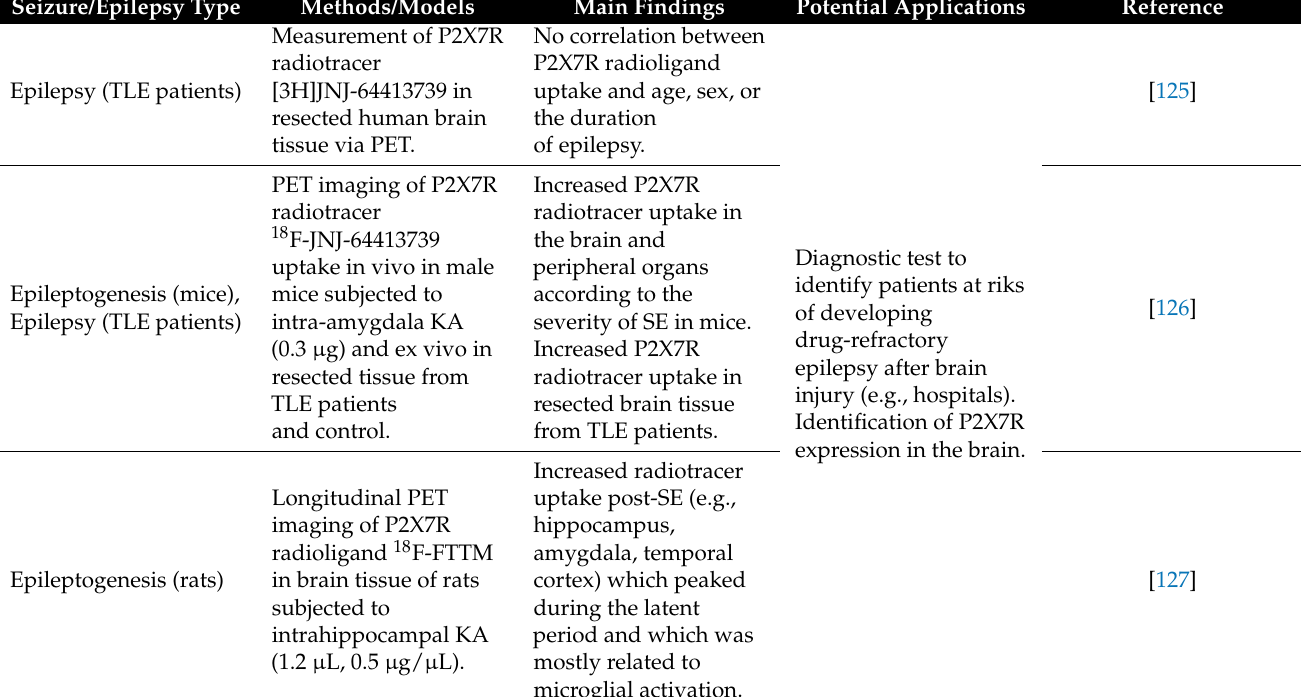
Table 2. Selected studies investigating the diagnostic potential of P2X7R for seizures and epilepsy. Seizure/Epilepsy Type